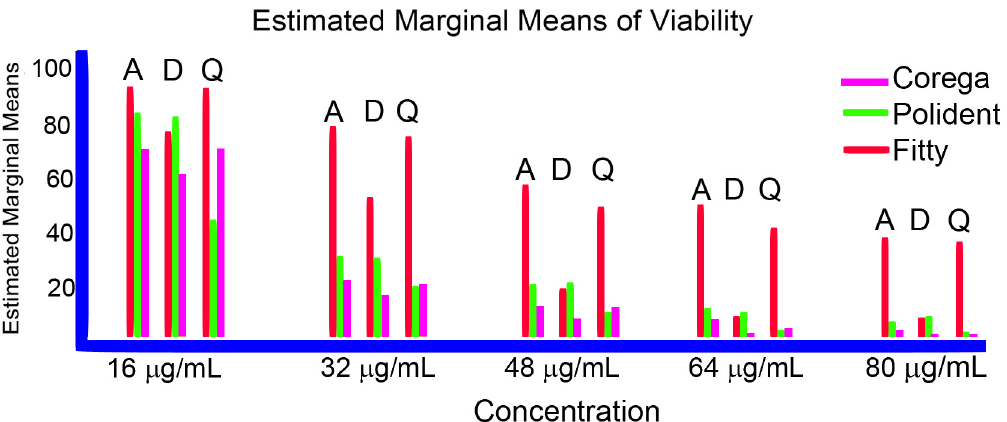
Figure 3- The graphics illustrated that an interaction effect is among resin*tablet at all concentration